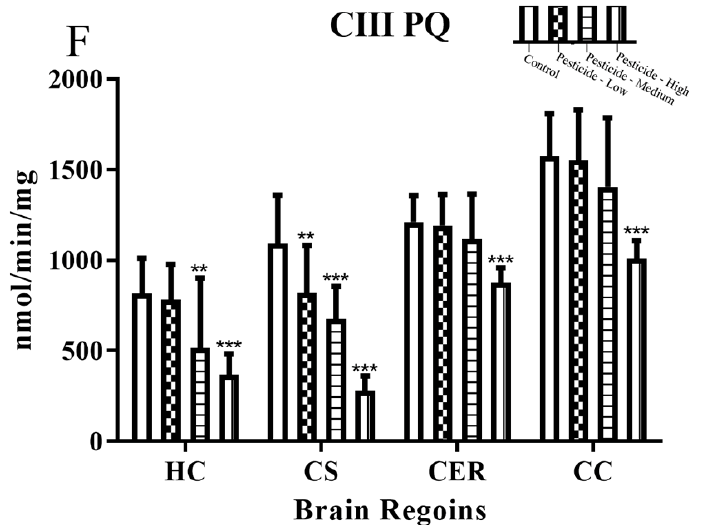
Figure 3. Pesticide-induced inhibition of mitochondrial complex I and complex III activities. Rats were dosed with malathion (MAL) ( A , D ); chlorpyrifos (CPF) ( B , E ); or paraquat (PQ) ( C , F ); at low, medium, or high dosages and the activity of mitochondrial complex I and complex III enzymes quantified within the hippocampus (HC), corpus striatum (CS), cerebellum (CER), and cerebral cortex (CC). Histograms are representative of mean values with SDs, with significant changes marked with asterisks, according to * p < 0.05, ** p < 0.01, and *** p < 0.001.